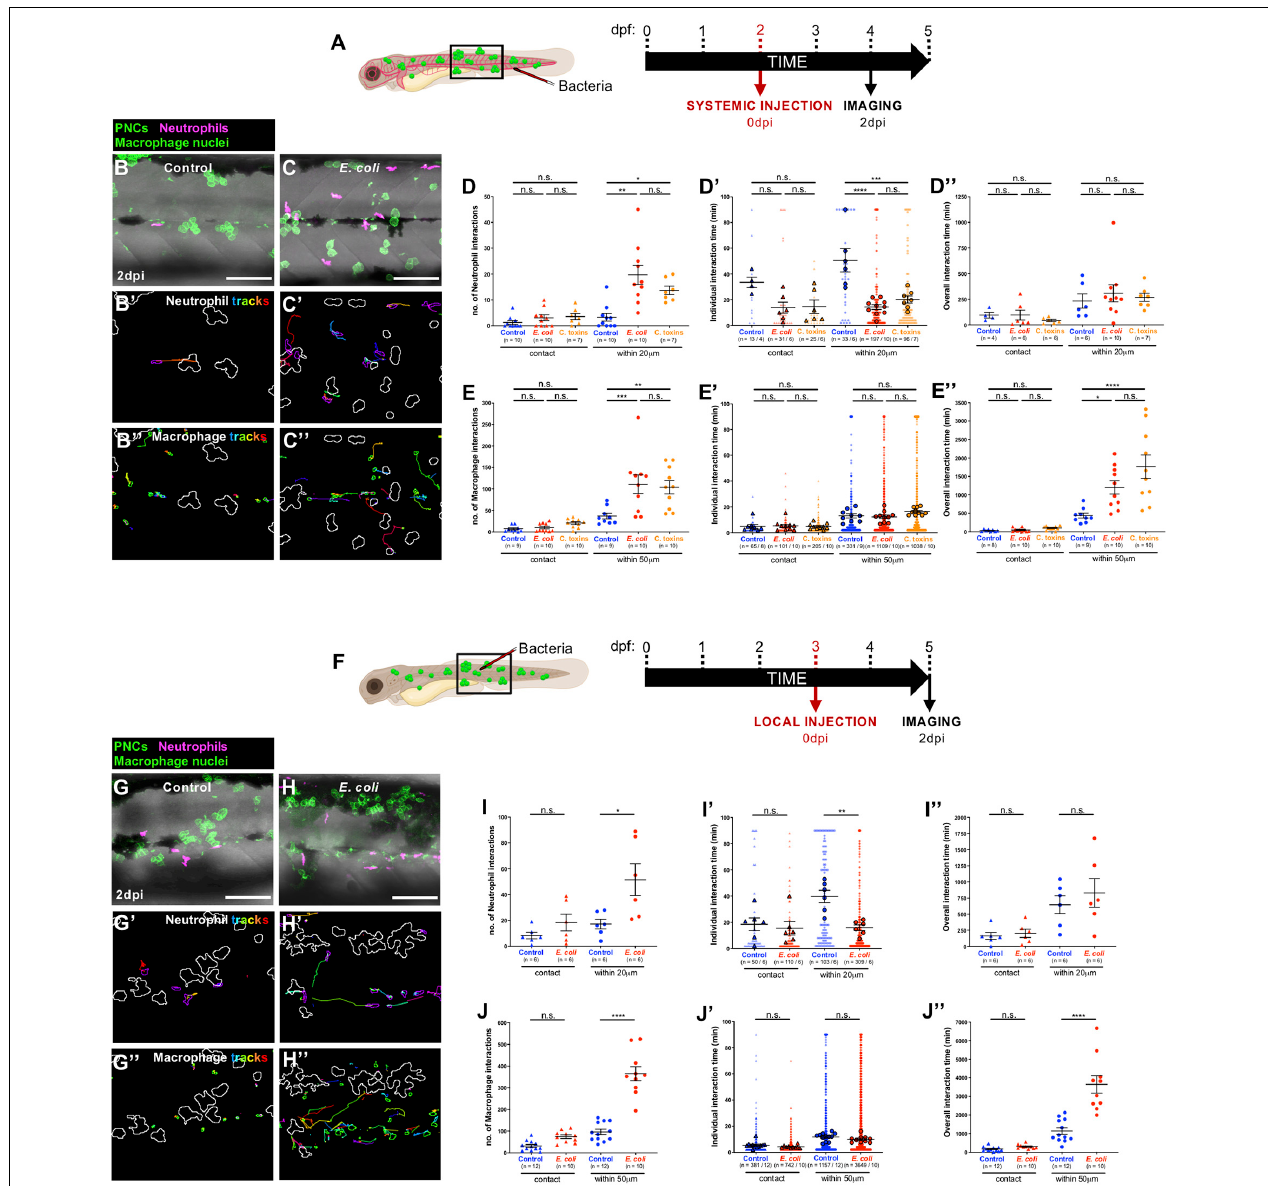
FIGURE 3 | Altered cancer inflammatory response upon E. coli or Coley’s toxins infection. (A) Schematic of the experimental timeline for systemically infected cancer studies showing the region (black box) to be imaged in (B,C) . (B,C) Multi-channel confocal movie frames of the flank of cancerous Tg( kita:HRASG12V-GFP;lyz:DsRed;mpeg1:nls-Clover ) larvae at 2 dpi after systemic injection of control media (B) or E. coli (C) , and prior to analysis of neutrophil (magenta) or macrophage (small green nuclei) behaviour and their interactions with pre-neoplastic cells (large green cells). (B’,C’,B”,C”) Post-software images of the same larvae showing neutrophils (magenta) (B’,C’) or macrophage nuclei (green) (B”,C”) and their tracks in the vicinity of pre-neoplastic clones (white lines indicate clonal margins). (D,E,D’,E’,D”,E”) . Graphs showing number and individual/overall duration of neutrophil-cancer (D,D’,D”) and macrophage-cancer (E,E’,E”) interactions. (F) Schematic of the experimental timeline for locally infected cancer studies showing the region (black box) to be imaged in (G,H) . (G–J,G’–J’,G”–J”) The same analysis was carried out for local infection as previously described for the systemic infection experiments. Scale bars = 100 µ